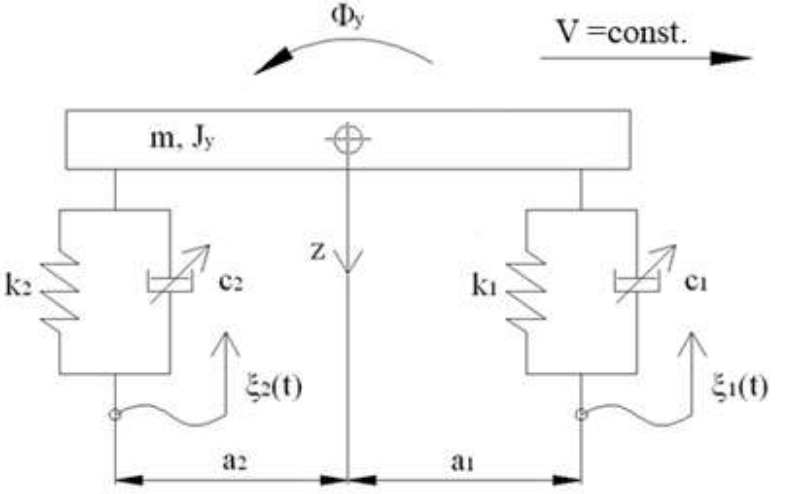
Figure 11. Model of vehicle and semi-active suspension: m—mass of body, J y – inertia of body, z—transfer axis, Φ y —angle rotation of body, V—velocity of a vehicle, a 1 , a 2 —distance from the center of gravity of the front axle (1), the rear axle (2), k 1 , k 2 —spring stiffness of the front suspension wheel (1), rear suspension wheel (2), c 1 , c 2 —damping coefficient in the front wheel suspension (1), the rear wheel suspension (2), 𝜉 1 , 𝜉 2 —kinematic excitation of the front wheel (1), the rear wheel (2).